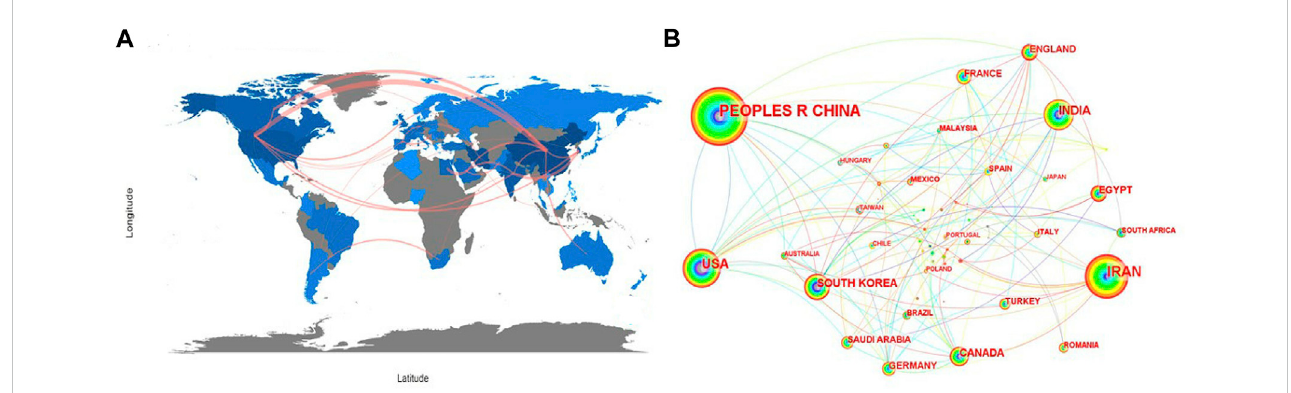
FIGURE 3 Cooperation of countries with regard to the applications of NHs for drug delivery. (A) The network map of cooperation relations between countries generated with R-Bibliometrix; (B) Visualized network map of cooperation relations between countries generated with CiteSpace.